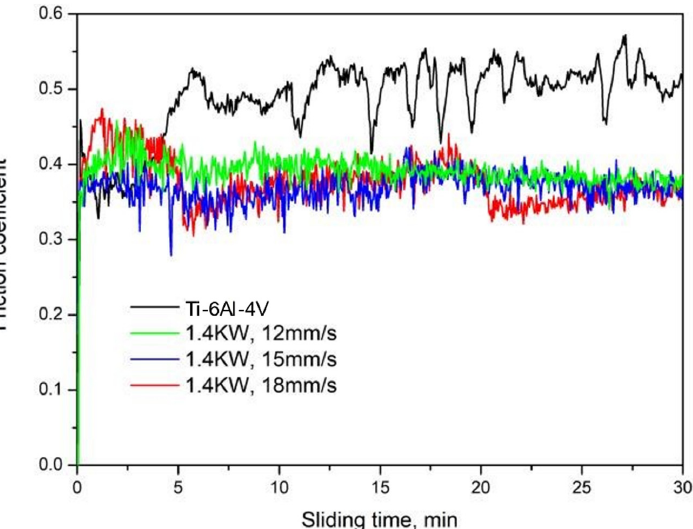
Figure 8. The friction coefficient curves of the substrate and coatings under different scanning